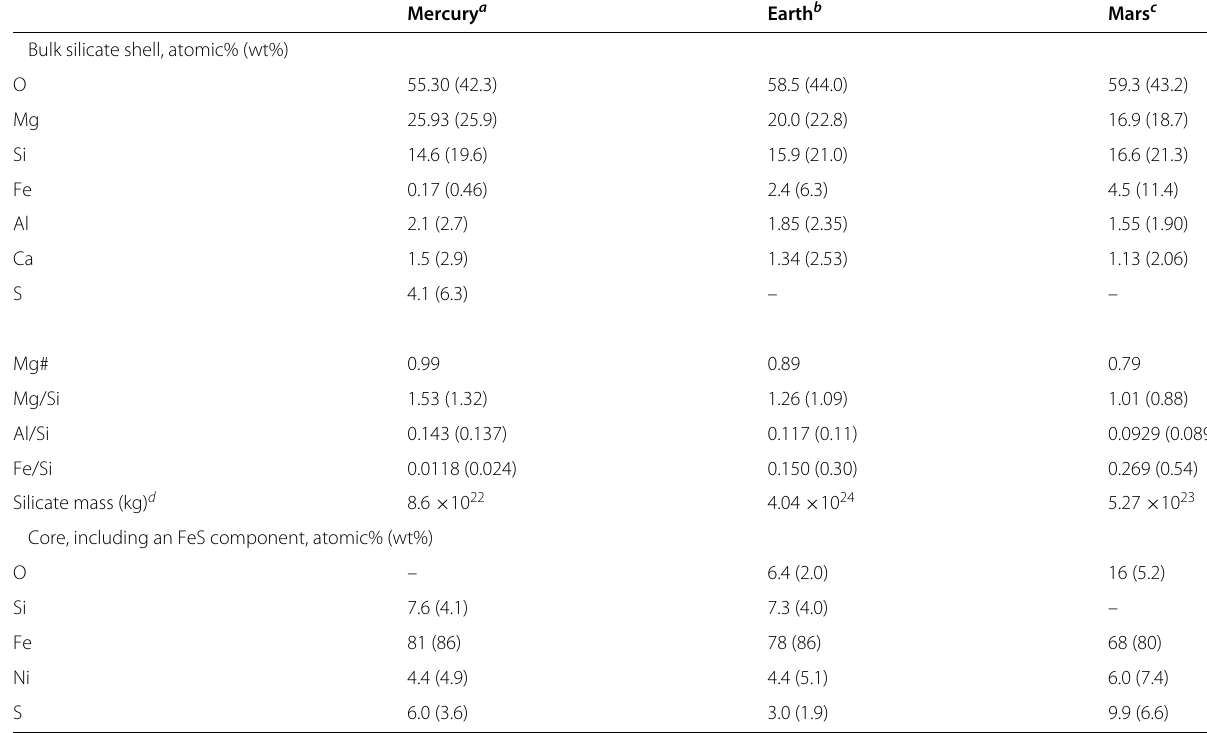
Table 2 Composition of silicate shells and metallic cores of the terrestrial planets Mercury a Earth